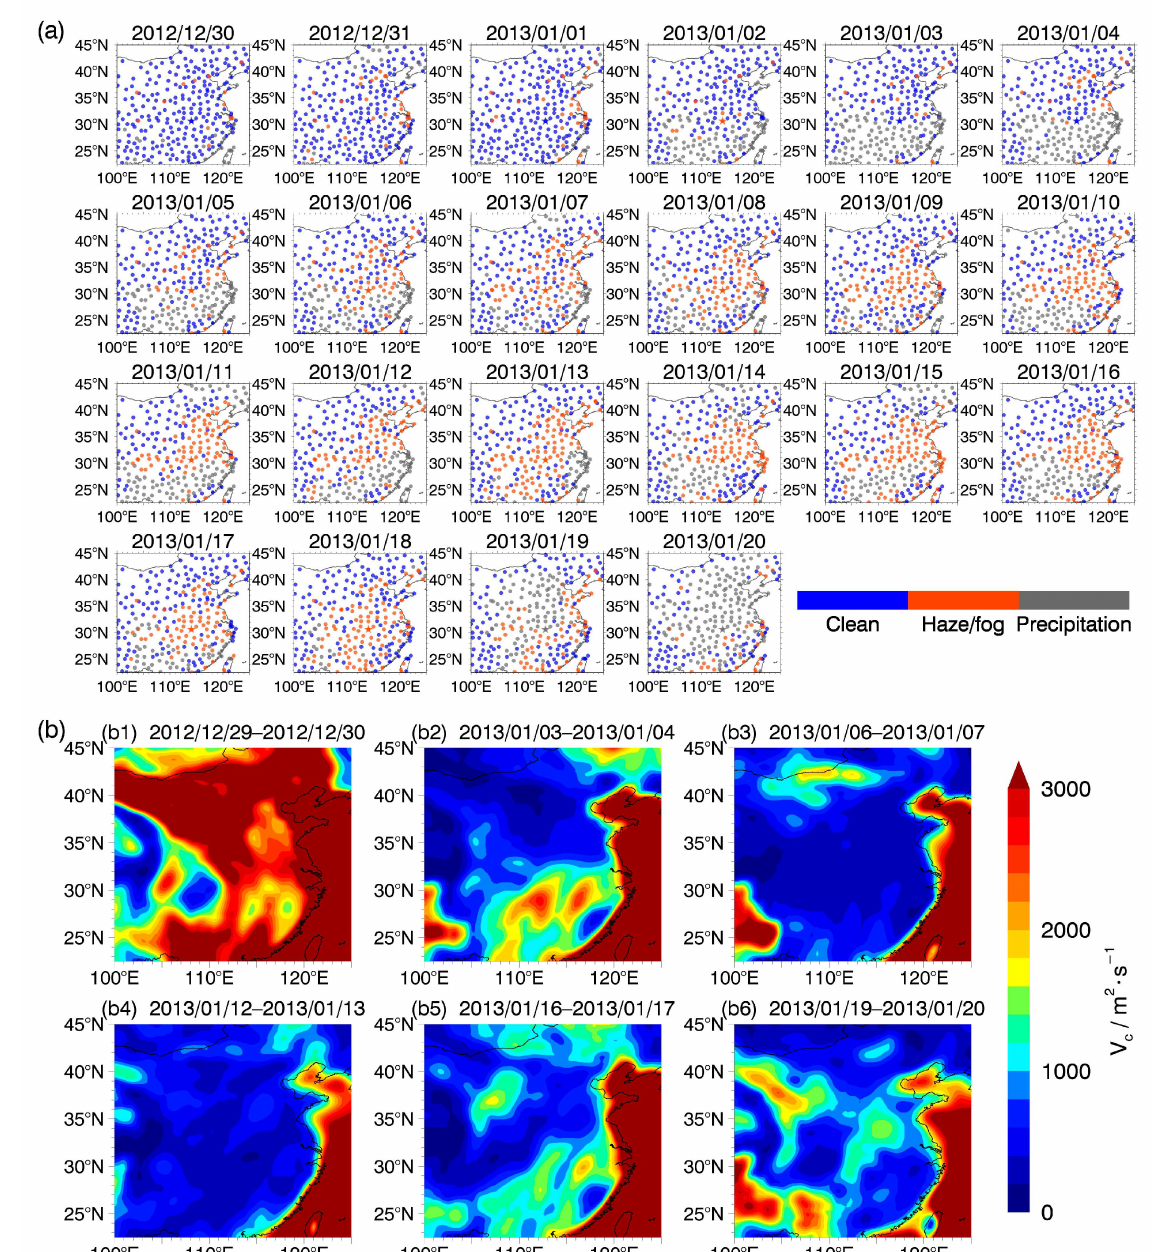
Figure 12. ( a ) Daily weather conditions of 268 Global Surface Summary of the Day (GSOD) sites over central and eastern China from 30 December 2012 to 20 January 2013. The blue, orange and gray dots denote the location of the sites with clear, haze/fog or precipitation weather, respectively. ( b ) The spatial extent of the ventilation coefficient (V c ) over central and eastern China for a sequence of 6 periods selected from 30 December 2012 to 20 January 2013.